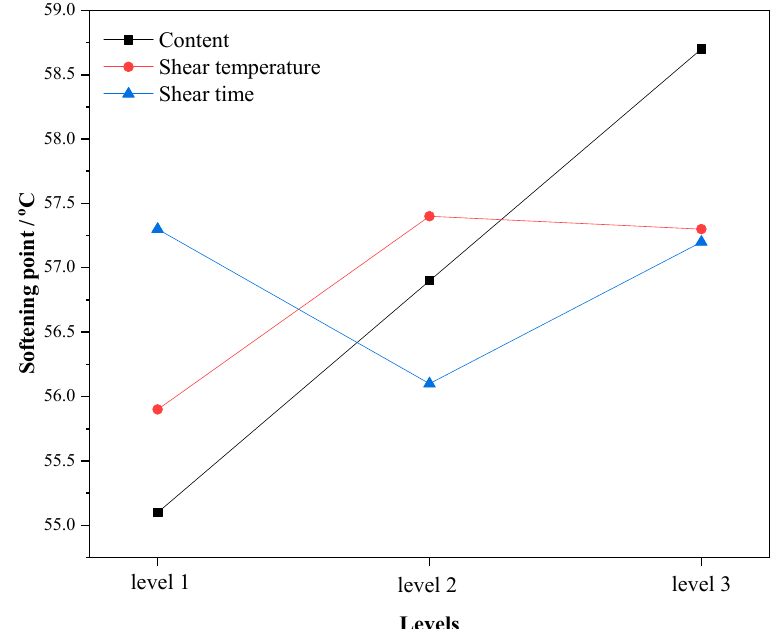
Figure 1. The variation of the mean softening point with the levels.